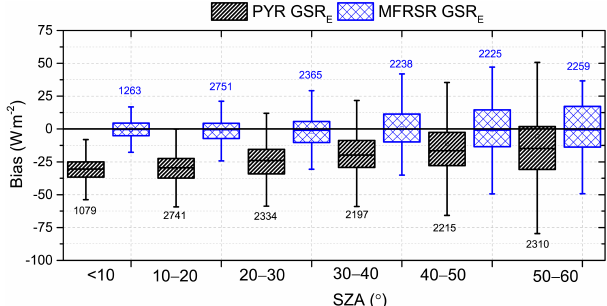
Figure 4. Box plot of the bias (PYR: black; MFRSR: blue) with respect to BSRN GSR E inWm − 2 at different ranges of SZA be- tween May and June 2015 (27 cloud-free days) at IZO. Box plots are defined as in Fig.